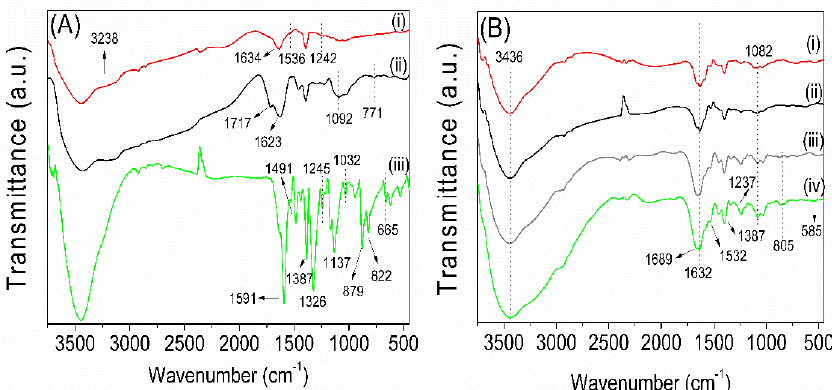
Figure 4. FTIR spectra of the precursors (GE, TN, and MB), and GE/TN-GO-MB hydrogels: ( A ) GE (i), TN (ii) and MB (iii); ( B ) 1-GE/TN-GO-MB (i), 2-GE/TN-GO-MB (ii), 3-GE/TN-GO-MB (iii), and 4-GE/TN-GO-MB (iv).